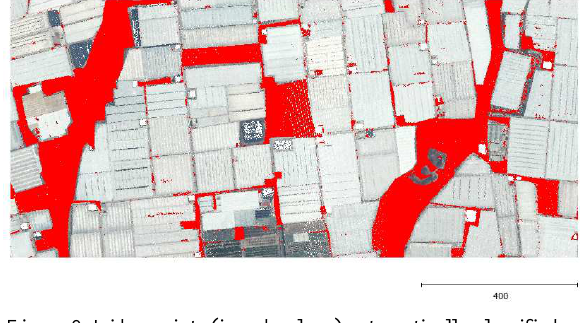
Figure 9. Lidar points (in red colour) automatically classified as “Ground” by applying LAStools software and manual edition